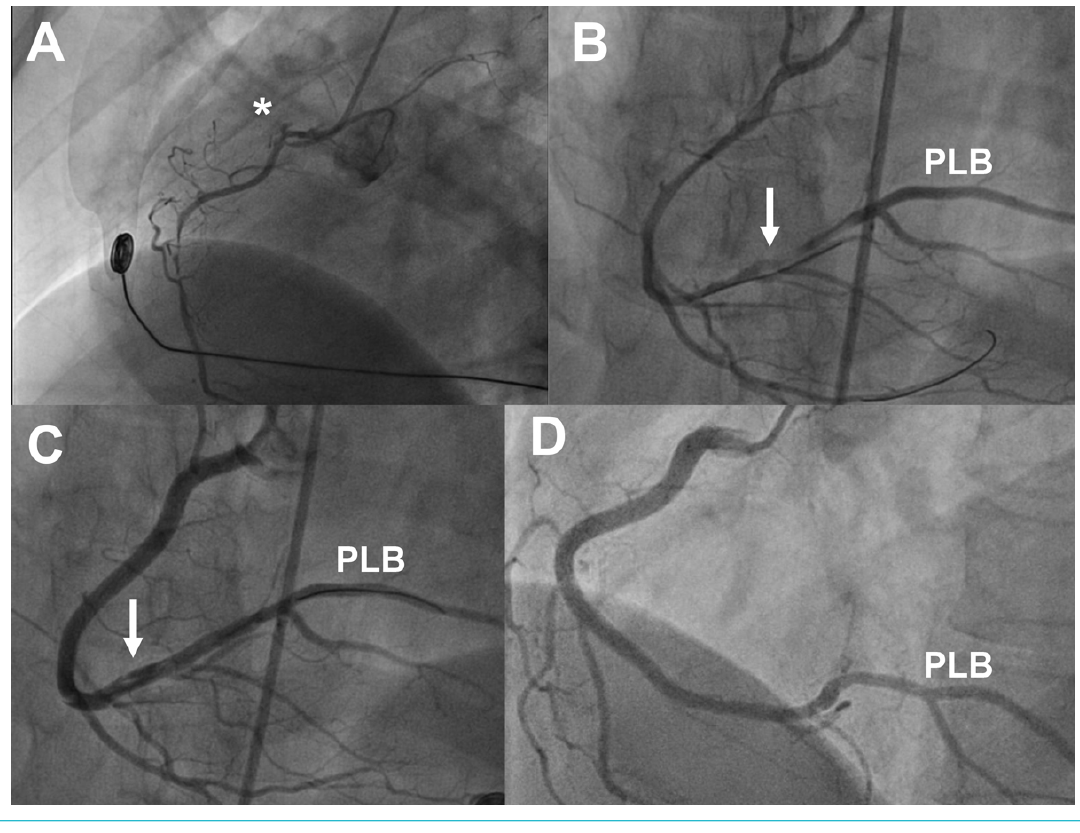
Figure 2: Angiograms of a 40-year-old female with inferolateral ST-segment elevation myocardial infarction, ongoing chest pain, and massive ECG ST-segment elevation at the time of angiography, treated by percutaneous coronary intervention. Panel A: left anterior oblique (LAO) 60° view showing extensive dissection of the right coronary artery (RCA) with minimal flow. B: cranial view showing extensive dissection of the RCA and the large posterolateral branch (PLB) after wiring of a large right ventricular branch and a side branch of the PLB. C: cranial view showing situation after correct wiring of the PLB and stenting of the mid to ostial RCA. The distal RCA and PLB are still dissected but were not stented. D: follow-up angiogram after 6 months. LAO 50°/cranial 15° view showing patent stents and angiographic healing of the dissection in the distal RCA and PLB.